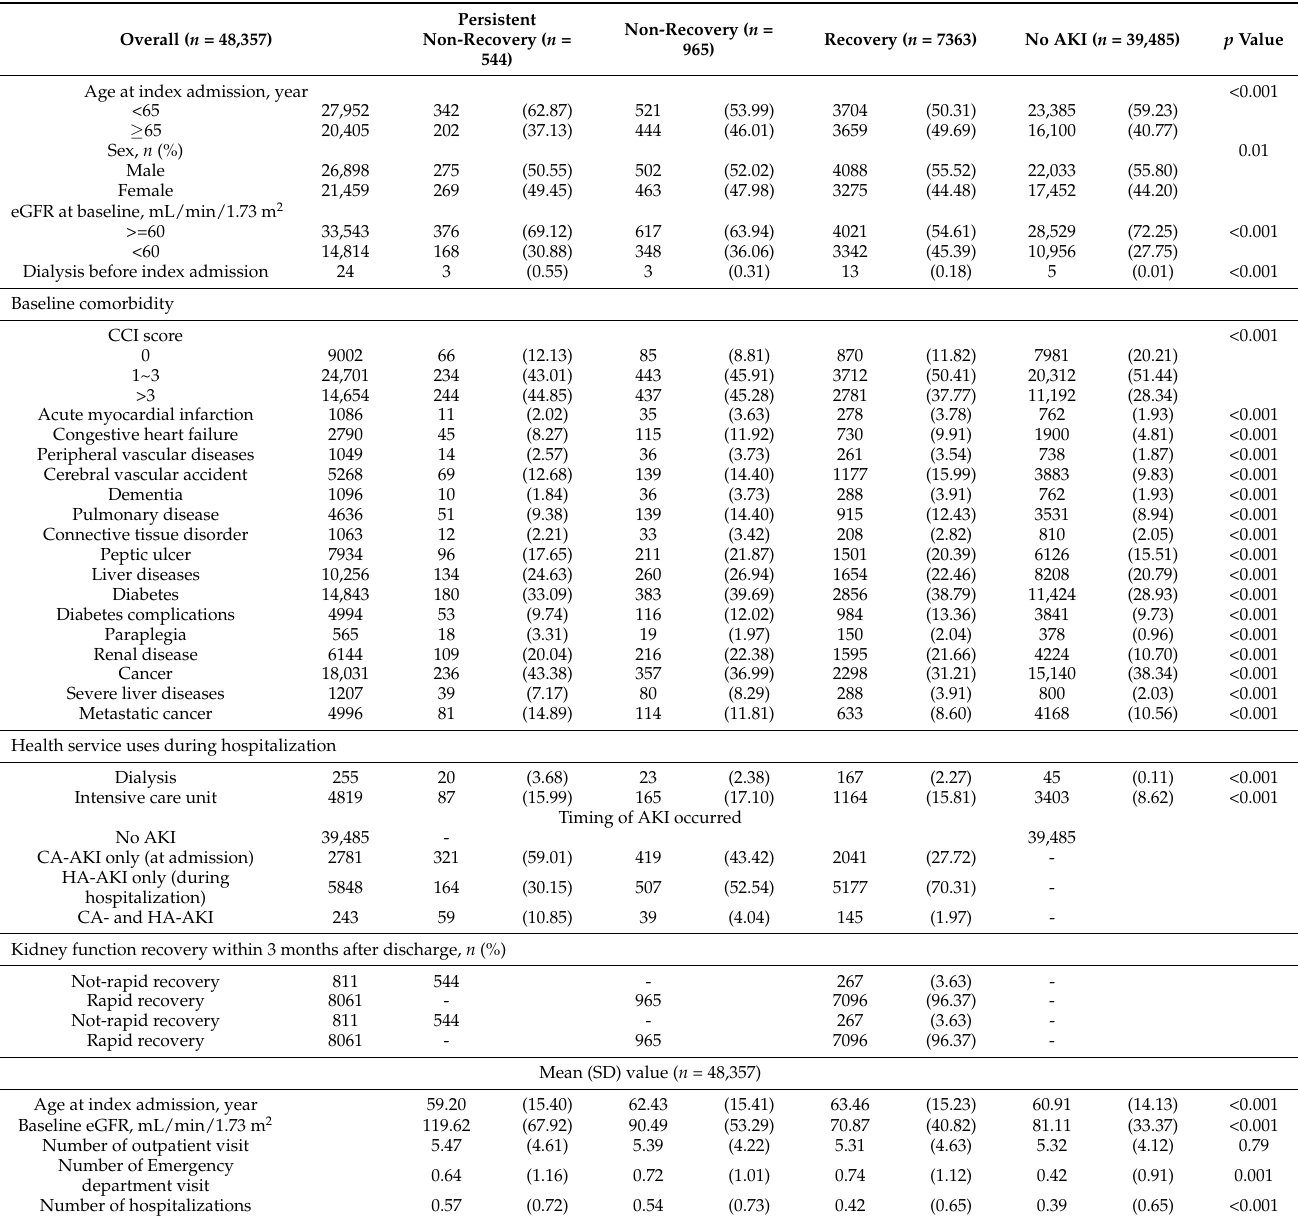
Table 1. Characteristics of study cohort in the analyses of adverse kidney